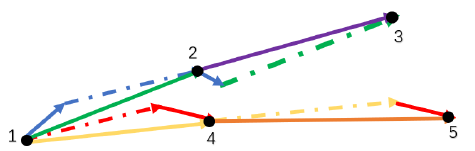
Figure 3. The paths of HB(1-2-3) and